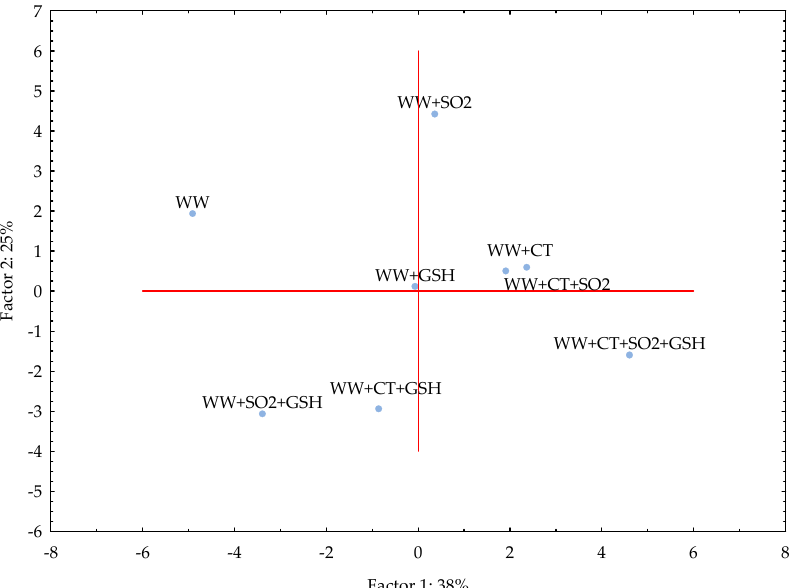
Figure 3. Principal Component Analysis (PCA) for the white wine (WW) stored in the dark after the light exposure. For samples coding refer to Table 6. Legend: SO 2 , sulphur dioxide (20 mg/L), GSH, glutathione (50 mg/L), CT, chestnut tannins (50 mg/L).